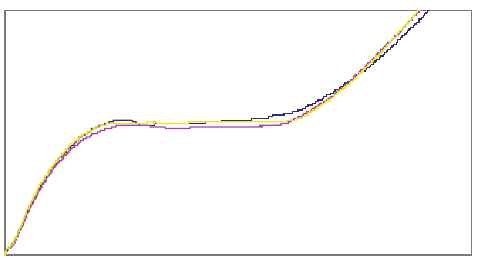
Figure 5 Three 2 mm diameter specimens of length 100 mm each subjected to a displacement rate of 7 mm/min.